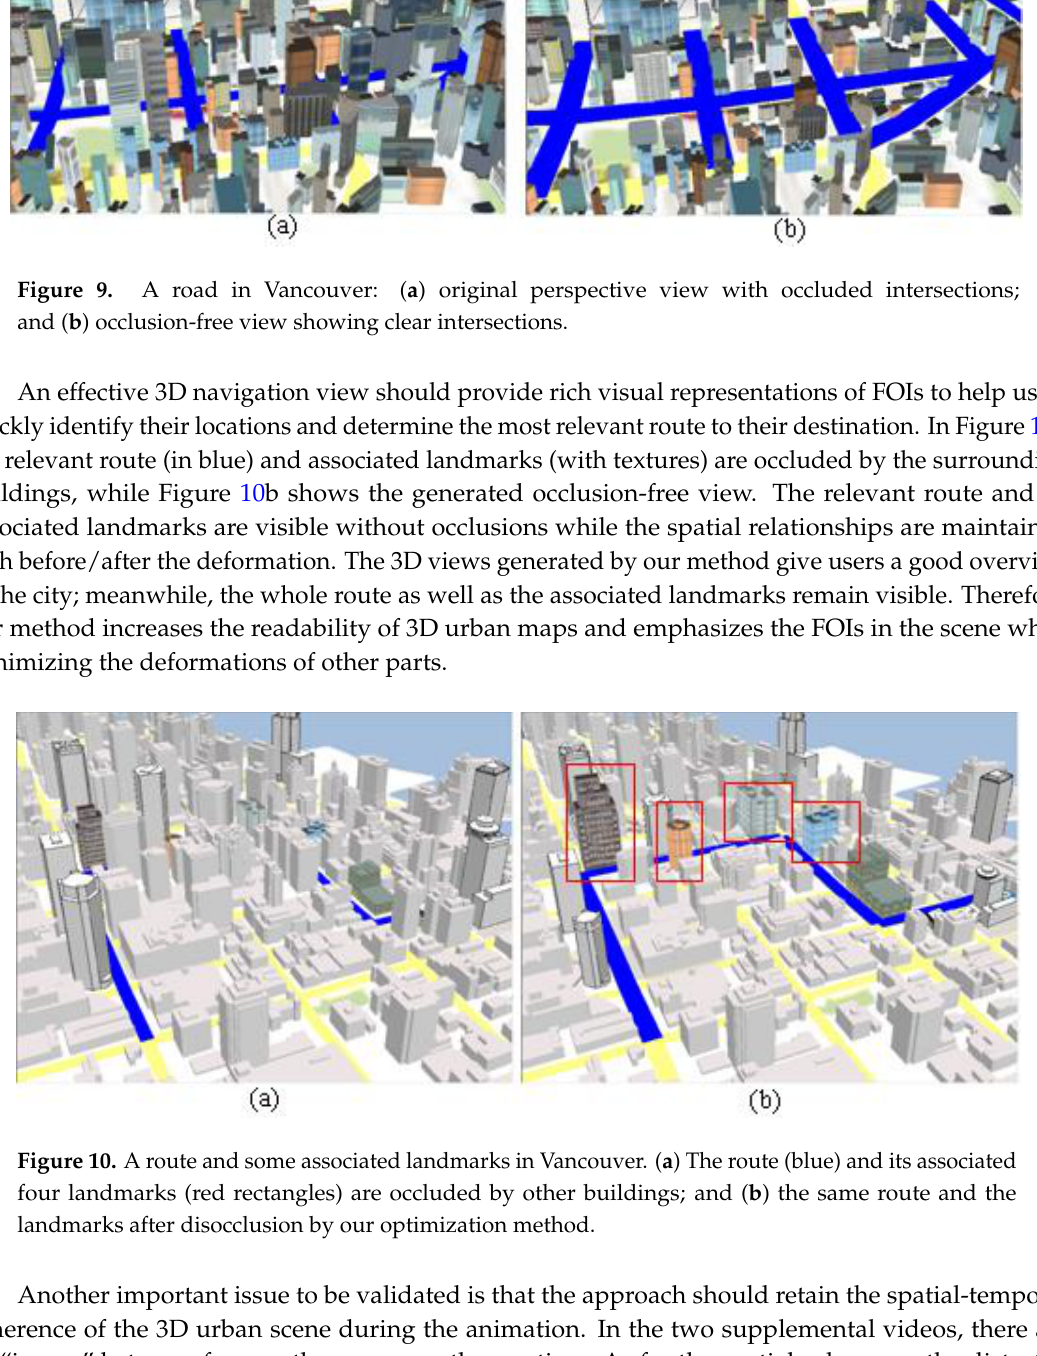
Figure 11. ( a ) An occlusion-free route network in Vancouver city; and ( b ) when the route is very complex, the buildings shown in the red rectangle may be over-scaled. The experiment provided quantitative results for the visualization processes. It demonstrates that the maximum displacement distance is less than 20 meters by Equation (25). We note that the maximum scaling along the Z-axis is typically larger than that along the X- and Y-axes. This occurs because scaling along the Z-axis is an efficient way to reduce occlusions. In these examples, we use the predefined parameters values introduced in Section 3. However, users can adjust them to obtain more preferable results. This adjustment will be introduced in Section 5.